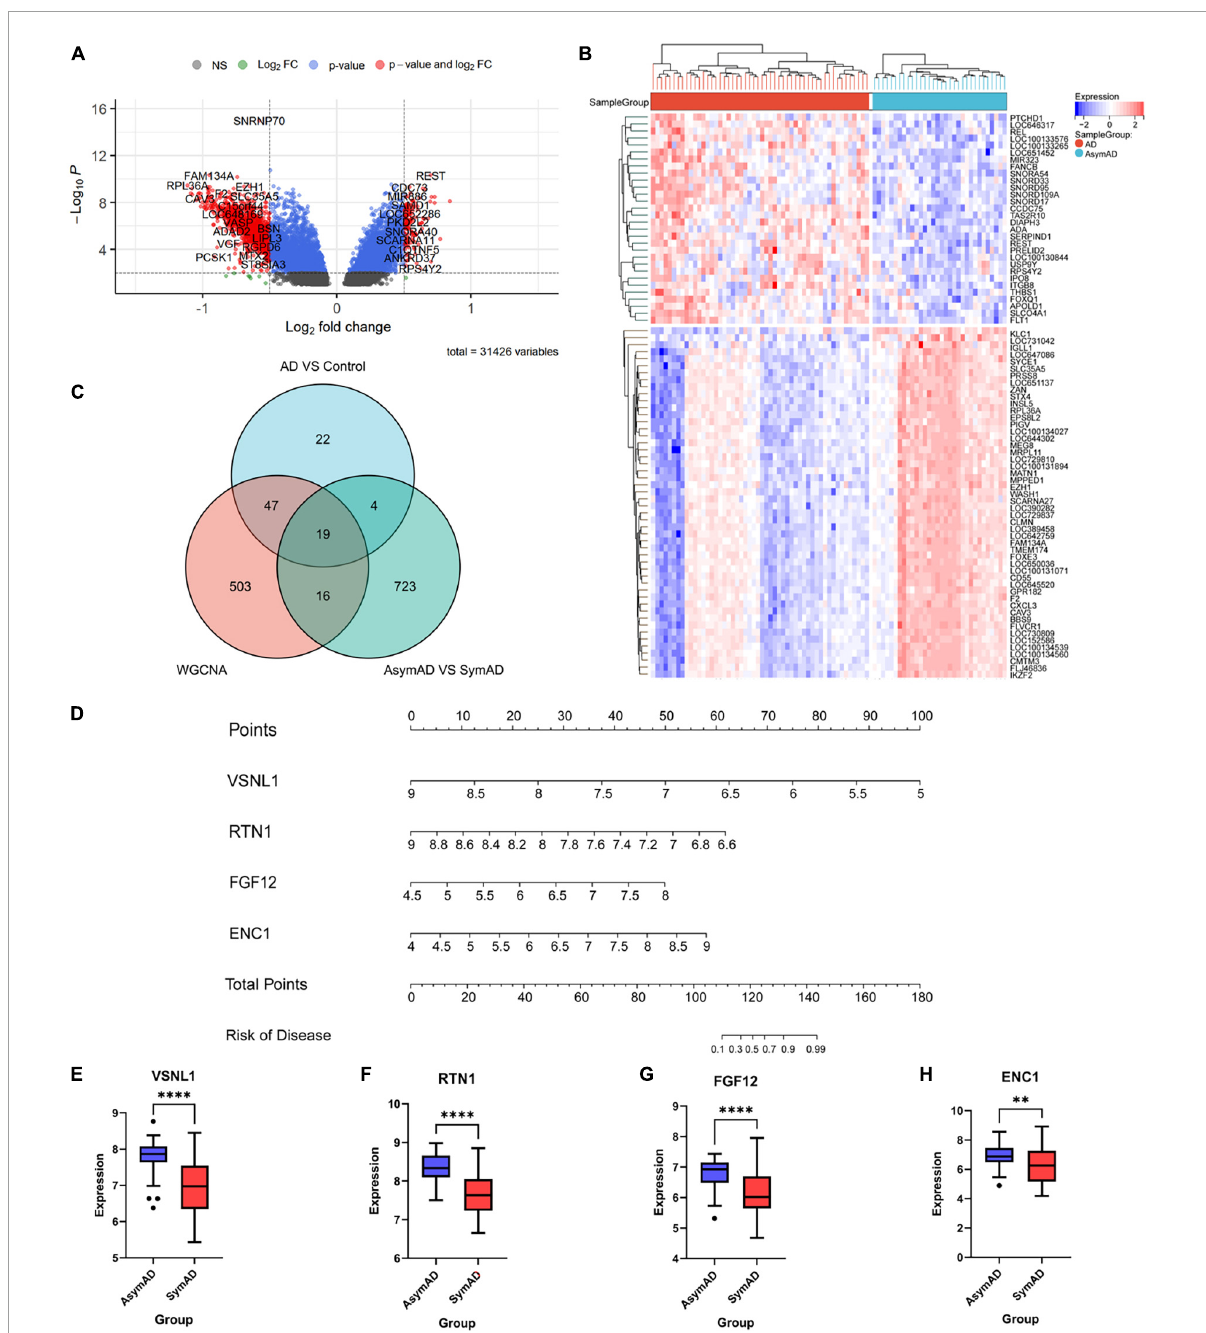
FIGURE5 The gene expression difference between AsymAD and SymAD. (A) The right red genes represent significantly high expression in SymAD; the left red genes represent increased expression in AsymAD. (B) The heatmap shows the top 50 genes predominantly expressed in AsymAD or SymAD. (C) Wayne diagram to intersection DEGs of three difference analysis. (D) Nomogram of four essential genes. (E–H) Expression differences of four critical genes in AsymAD and SymAD group. ** means p -value < 0.01; **** means p -value < 0.0001.